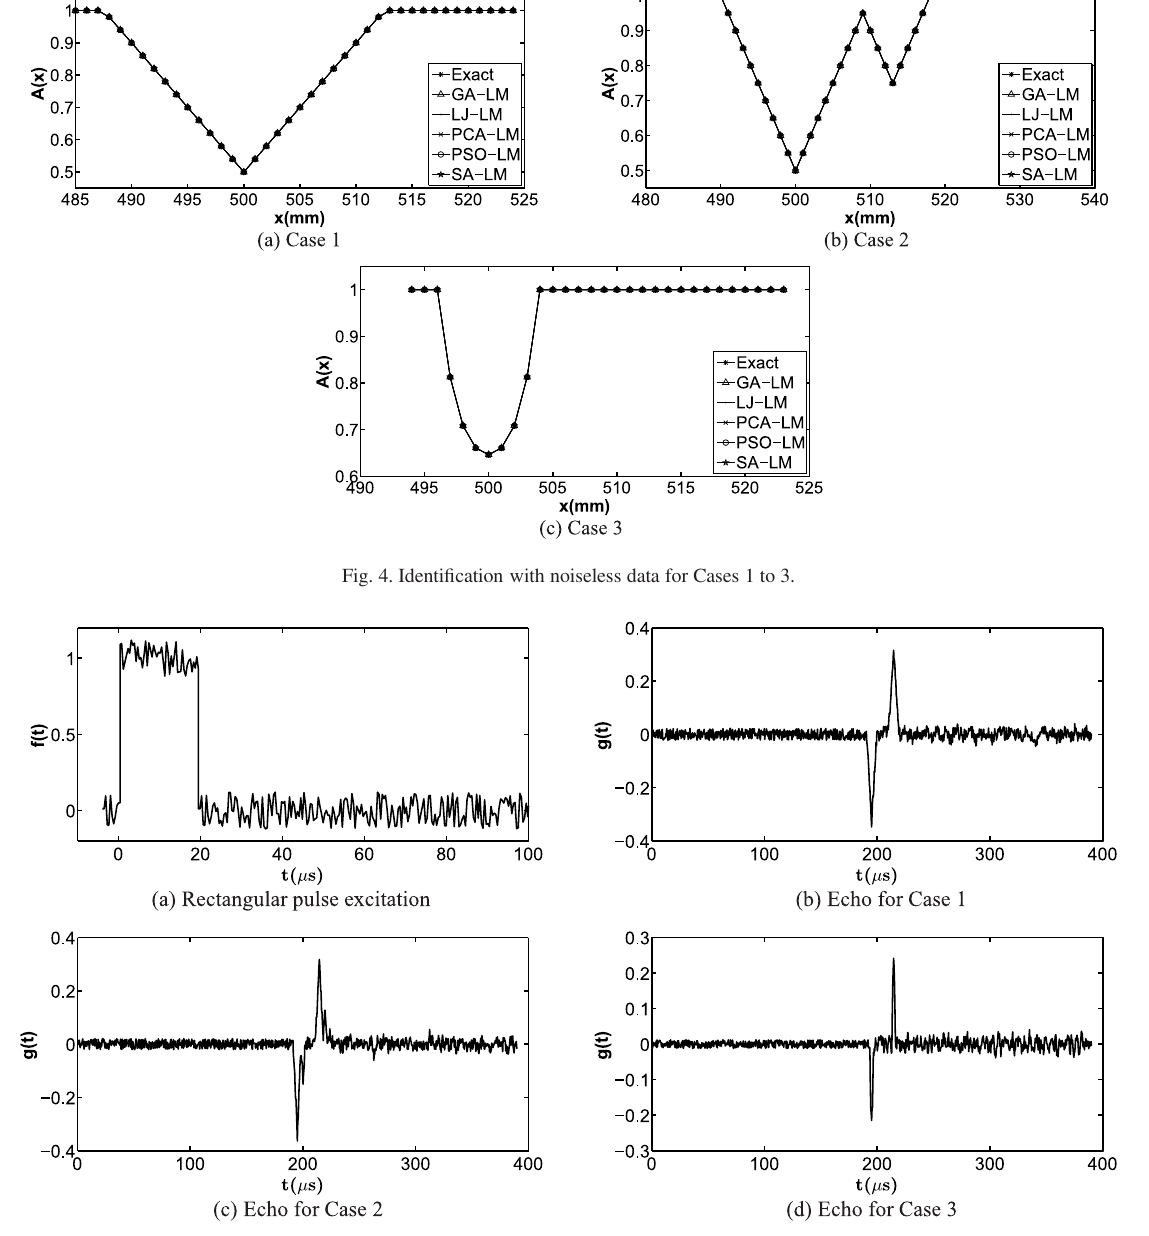
Fig. 5. Pulse and echo signals for Cases 1, 2 and 3 with a SNR = 10